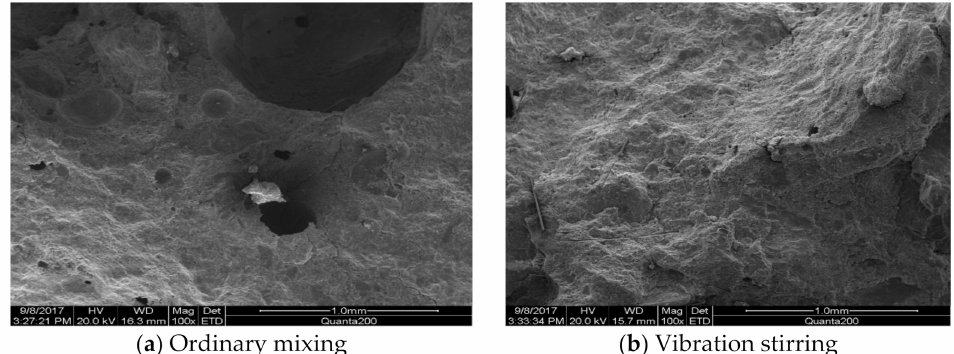
Figure 15. Comparison of morphology of concrete paste with low steel-fiber volume ratio. (Magnified 100 times). ( a ) Ordinary mixing ( b ) Vibration